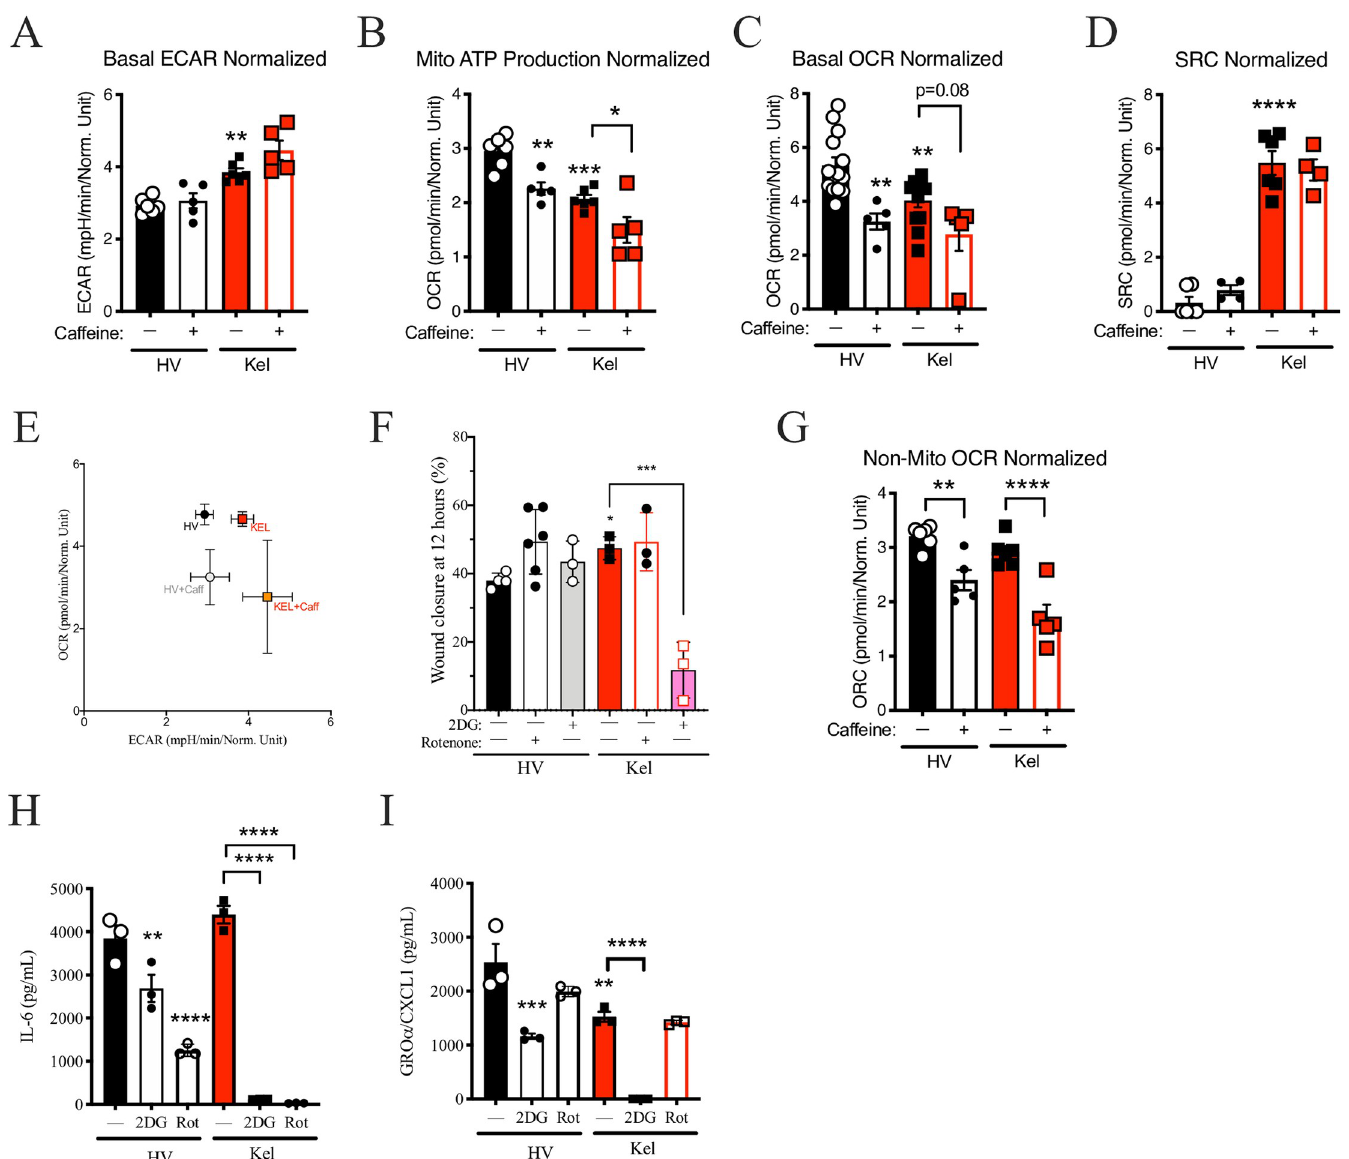
Fig 4. Caffeine impacts metabolic function. Seahorse assay was performed on fibroblast cell lines (FB) from healthy volunteer (HV) or keloid scars (Kel). Results for extracellular acidification rate (ECAR; a measure of glycolysis; A), mitochondrial (mito) ATP production (B), basal oxygen consumption rate (OCR; C), spare respiratory capacity (SRC; D), and ratio of basal ECAR to OCR (E) are shown. (F) Wound closure at 12 hours for keloid FB or healthy FB with treatment with diluent, the glycolysis inhibitor 2DG, or the mitochondrial OxPhos inhibitor rotenone. (G) Seahorse results for non-mitochondrial OCR for cells treated with diluent or caffeine. (H-I) Supernatant accumulation of interleukin (IL-) 6 (H) and CXCL1 (I). Results are representative of two independent experiments and displayed as mean + SEM with dots indicating replicate wells. � = p < 0.05; �� = p < 0.01; ��� = p < 0.001; ���� = p < 0.0001 as determined by ANOVA with Sidak